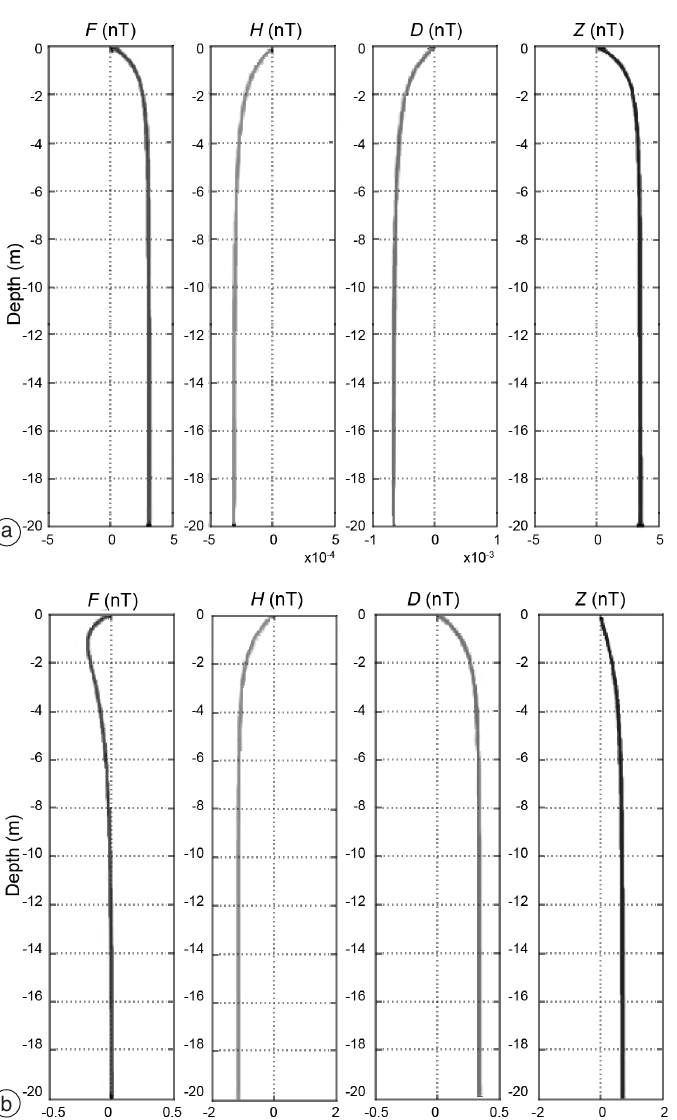
Fig. 5a,b. Depth dependence of the contribution from the cylindrical surface of a borehole: a) 2.5 m just above the outlet of a borehole; b) 2 m north and 2.5 m above the